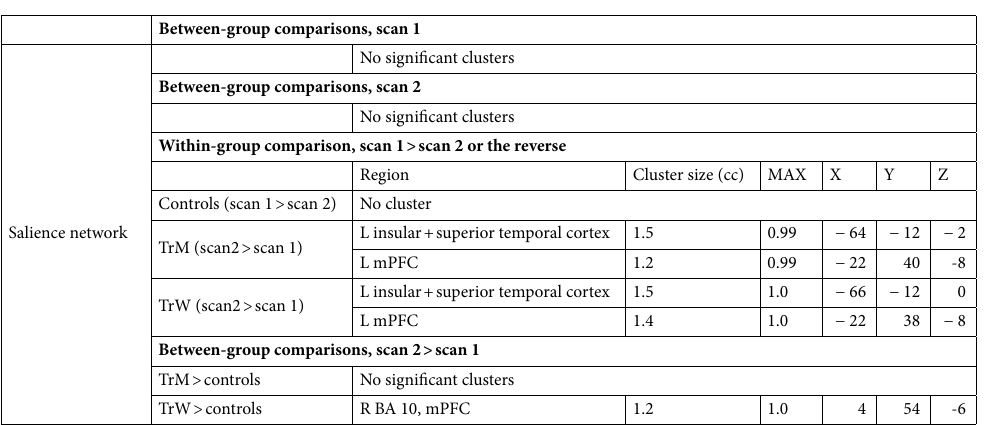
Table 4. Connectivity in salience network before (scan 1) and after (scan 2) cross-sex hormone treatment in TR persons, (no treatment in controls). mPFC, mesial prefrontal cortex; lPFC, lateral prefrontal cortex; ACC, anterior cingulate cortex. Calculations at 1 − p > 0.98, cluster size > 1.0